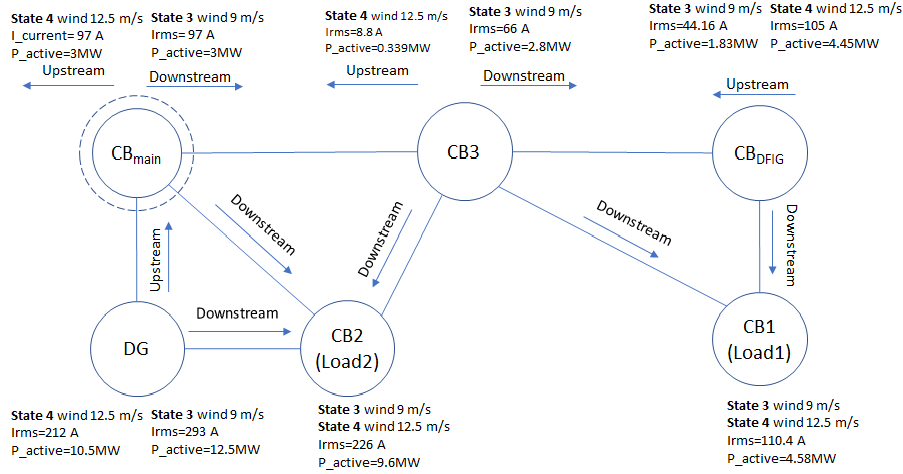
Figure 8. State transitions due to variation in DFIG system operation conditions.